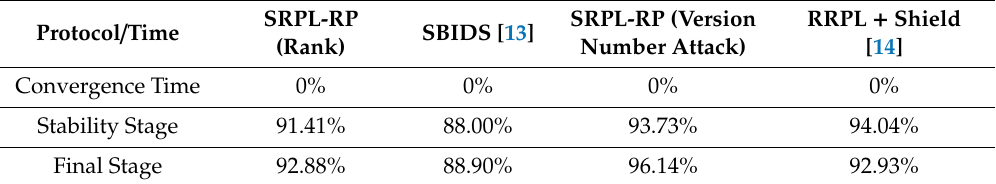
Table 13. Accuracy Rate (AR) Comparison Grid-Random Topology.